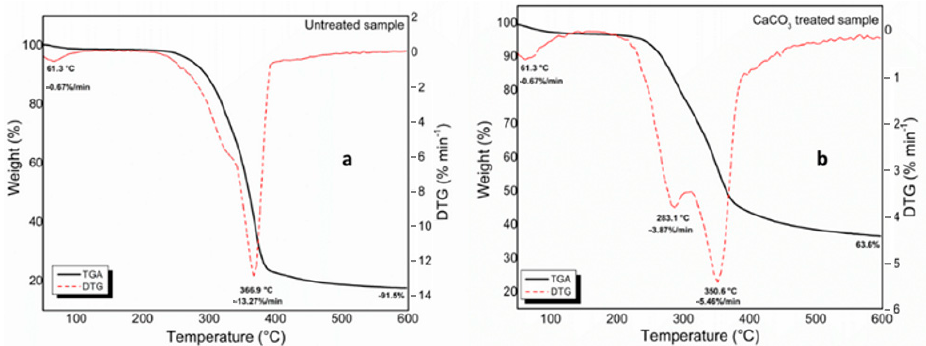
Figure 5. TGA and DTG analysis of ( a ) an untreated wood sample and ( b ) a sample treated with CaCO 3